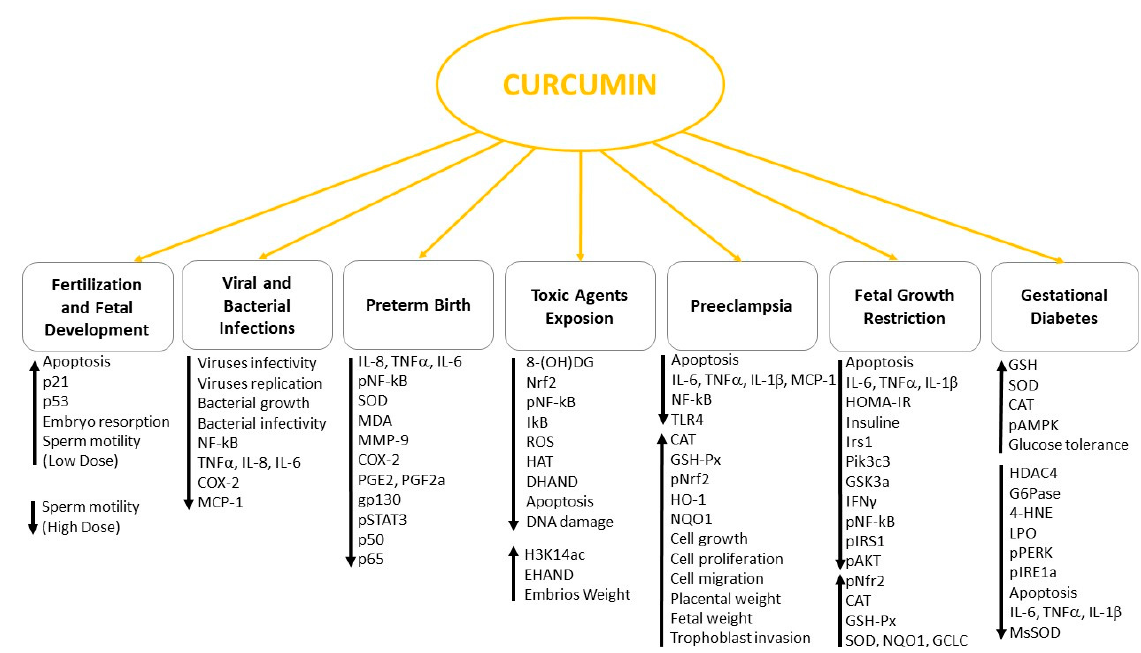
Figure 2. Curcumin effects on pregnancy disorders.